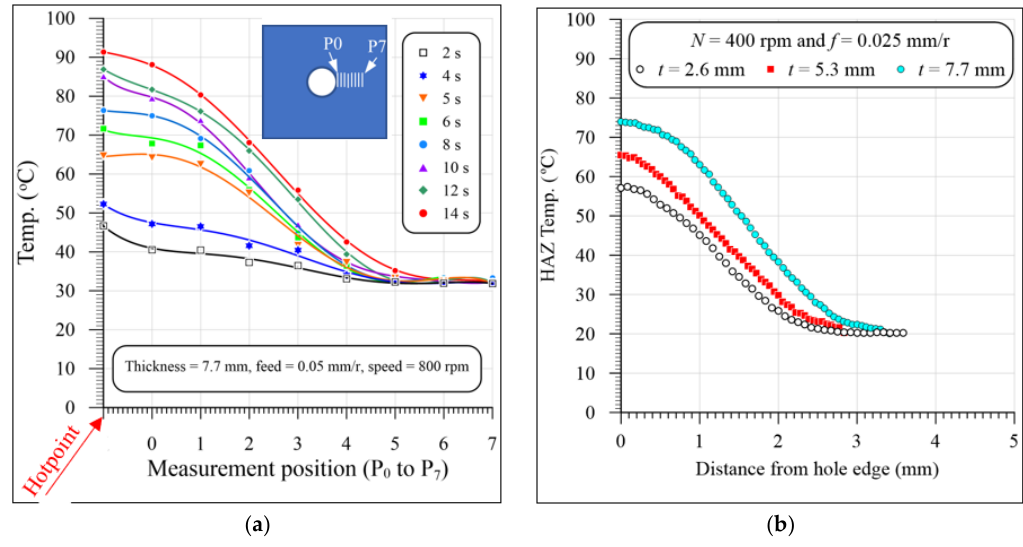
Figure 6. Representative sample of temperature distribution of the heated zone: ( a ) during cutting process (time) at 800 rpm, and 0.05 mm/r, and ( b ) effect of specimen thickness at 400 rpm, and 0.025 mm/r.